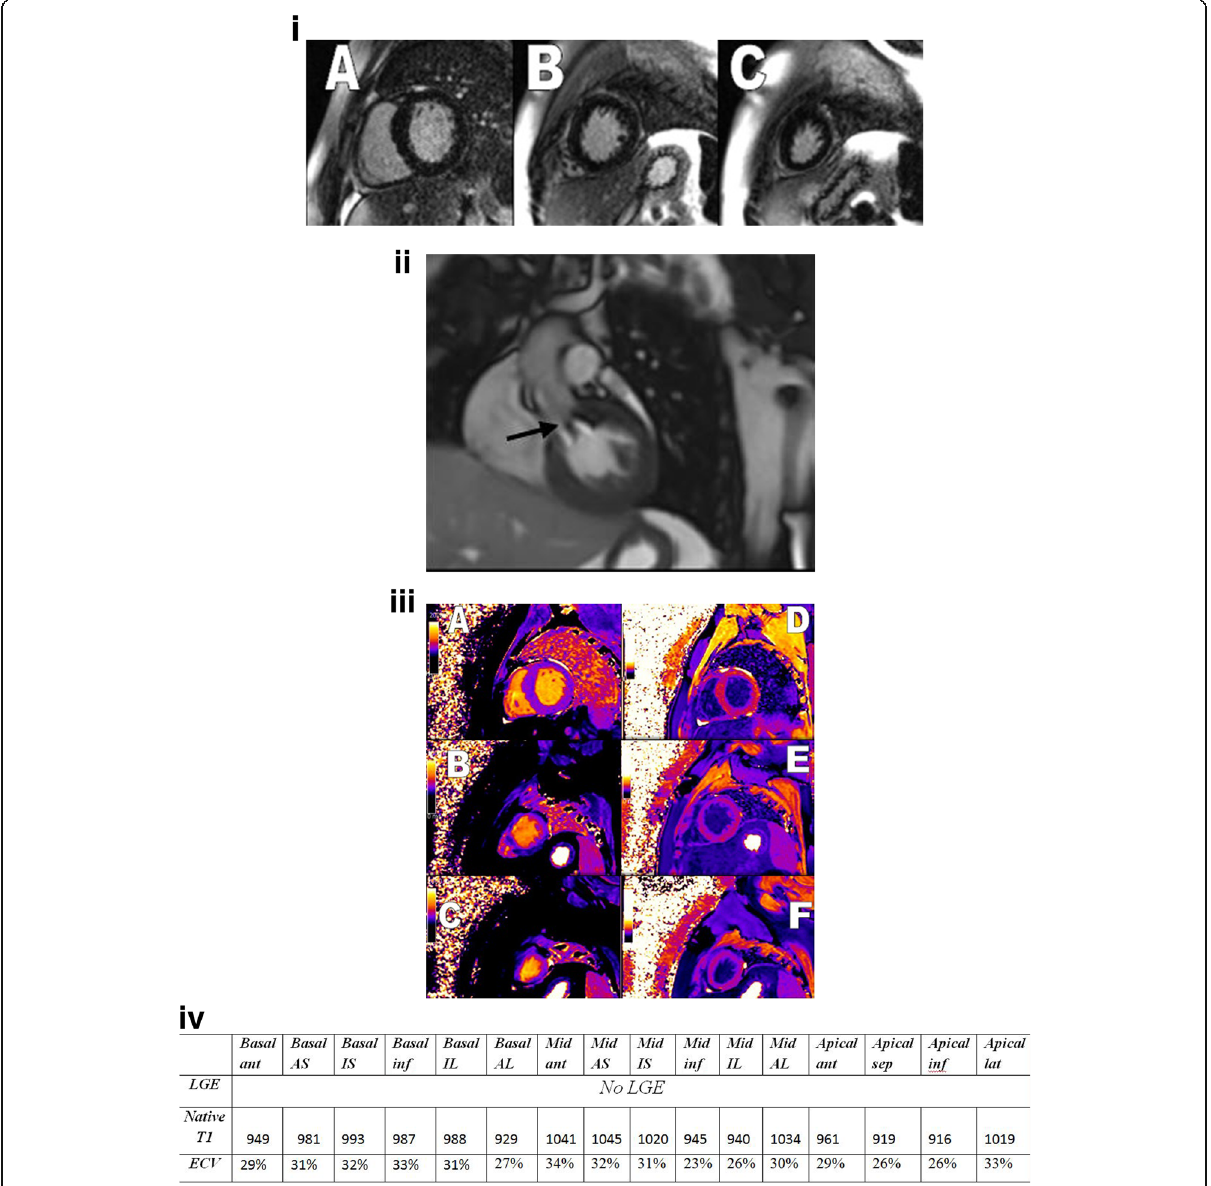
Fig. 3 Case 1: 26-year-old male patient. MRI showed asymmetric LV hypertrophy having anteclockwise pattern, maximum thickness of 17 mm affecting the basal antero-septal segment, LVOT obstruction with a peak velocity of 3 m/s, SAM and LV mass of 245 g (indexed 127 g/m 2 ). I: LGE images at the basal ( a ), mid-ventricular ( b ), and apical ( c ) levels corresponding to the T1 mapping cuts showing no significant enhancement. II: SSFP image in LVOT view showing candle flame artifact of LVOTO (arrow). III: pre-contrast ( a – c ) and post-contrast ( d – f ) T1 mapping images at the basal ( a , d ), mid-ventricular ( b , e ), and apical ( c , f ) levels. IV: enhancement pattern and values of native T1 and ECV at the basal, mid-ventricular, and apical segments showing no evidence of myocardial enhancement yet ECV expansion in 9 of the 16 cardiac